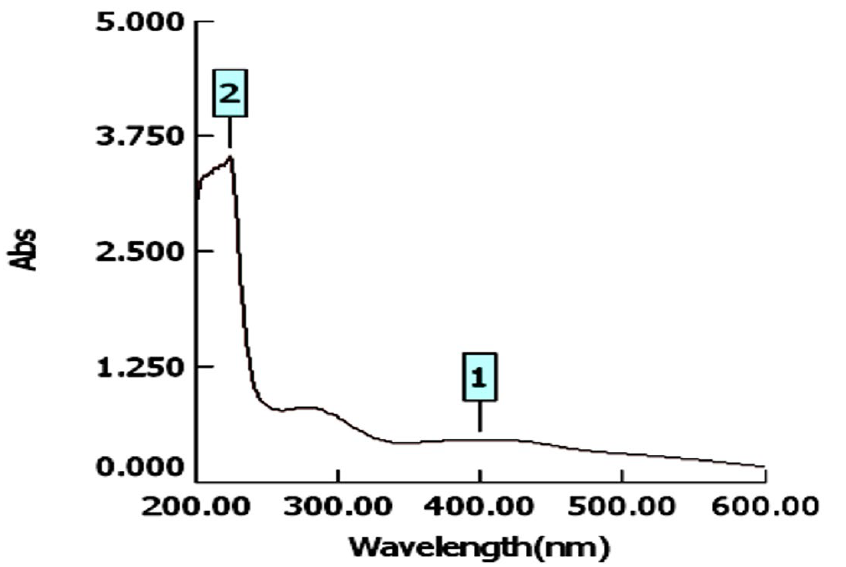
Fig. 1. The UV-Visible spectrum showing the absorption peak of of AgNPs at 400